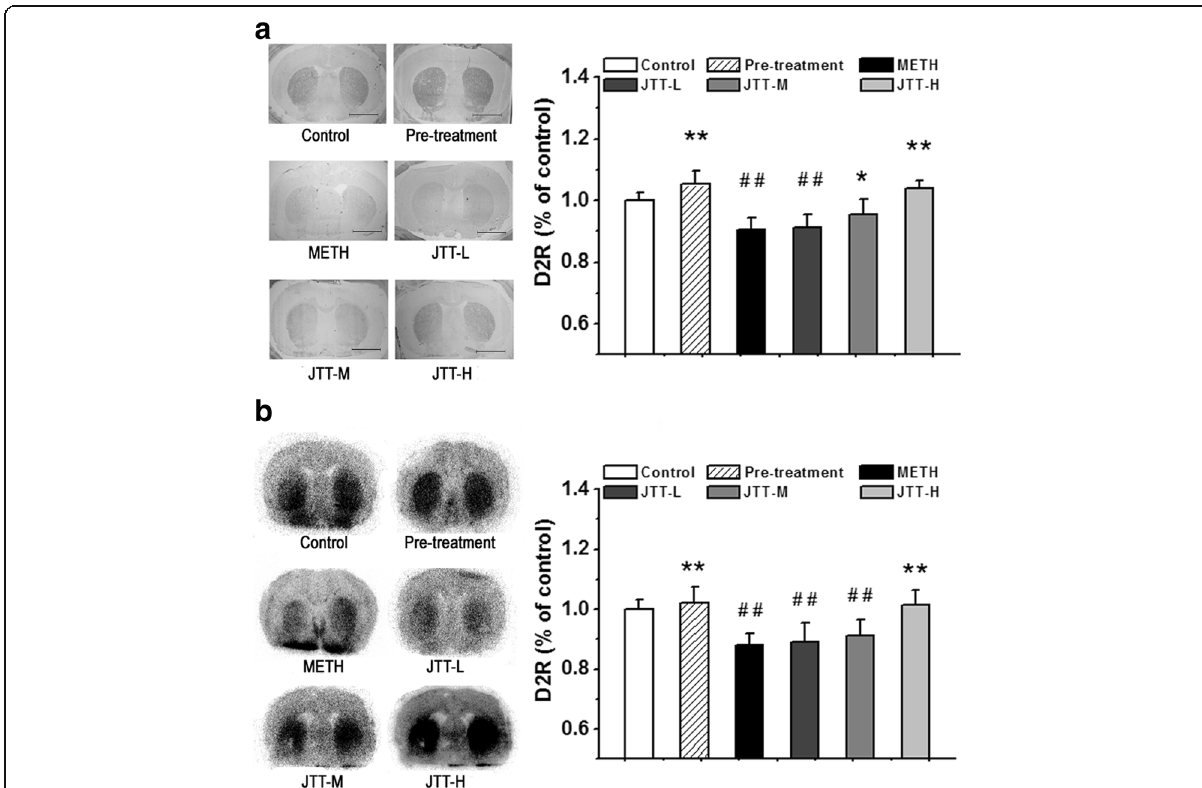
Fig. 3 Effects of Jitai tablet (JTT) on dopamine D2 receptor (D2R) levels in the striatum by immunohistochemical staining ( a ) (Bar = 5.00 mm) and autoradiography with [ 125 I]IBZM ( b ). The significant decrease of D2R expression in the striatum was inhibited by JTT pre-treatment, or significantly attenuated by post-treatment with high dose of JTT (JTT-H). Data are expressed as mean ± SD (n = 5). METH group vs. control group: # p < 0.05, ## p < 0.01; JTT treatment group vs METH group: * p < 0.05, ** p <